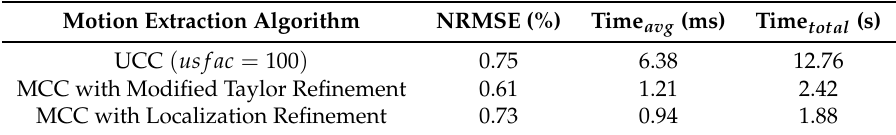
Table 2. Error and time consumption comparisons in the moving platform experiment.